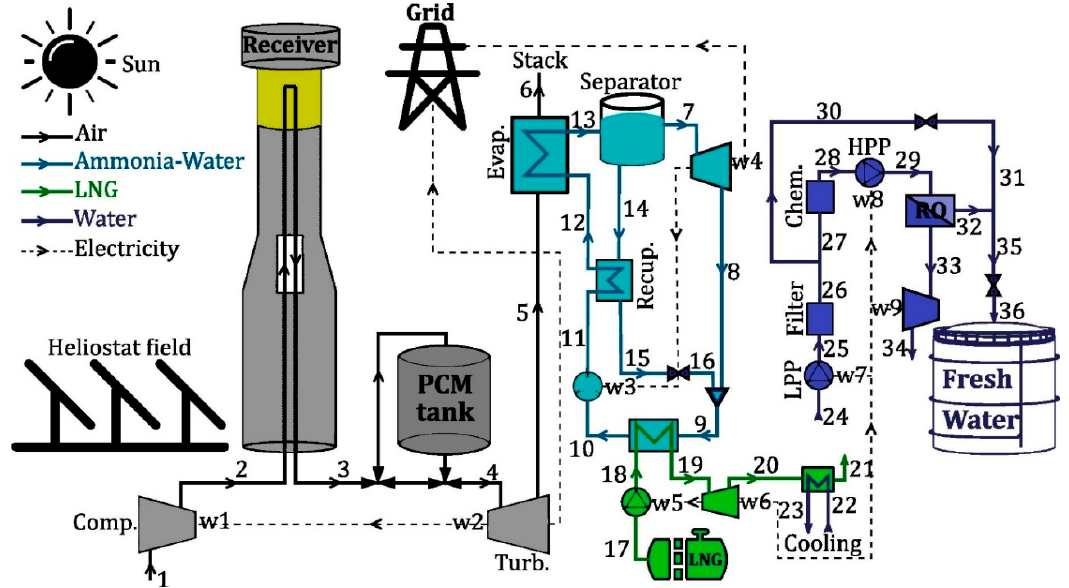
Figure 17. Schematic of the proposed integrated system [152], reused with permission from Elsevier (license number 5491451264329).